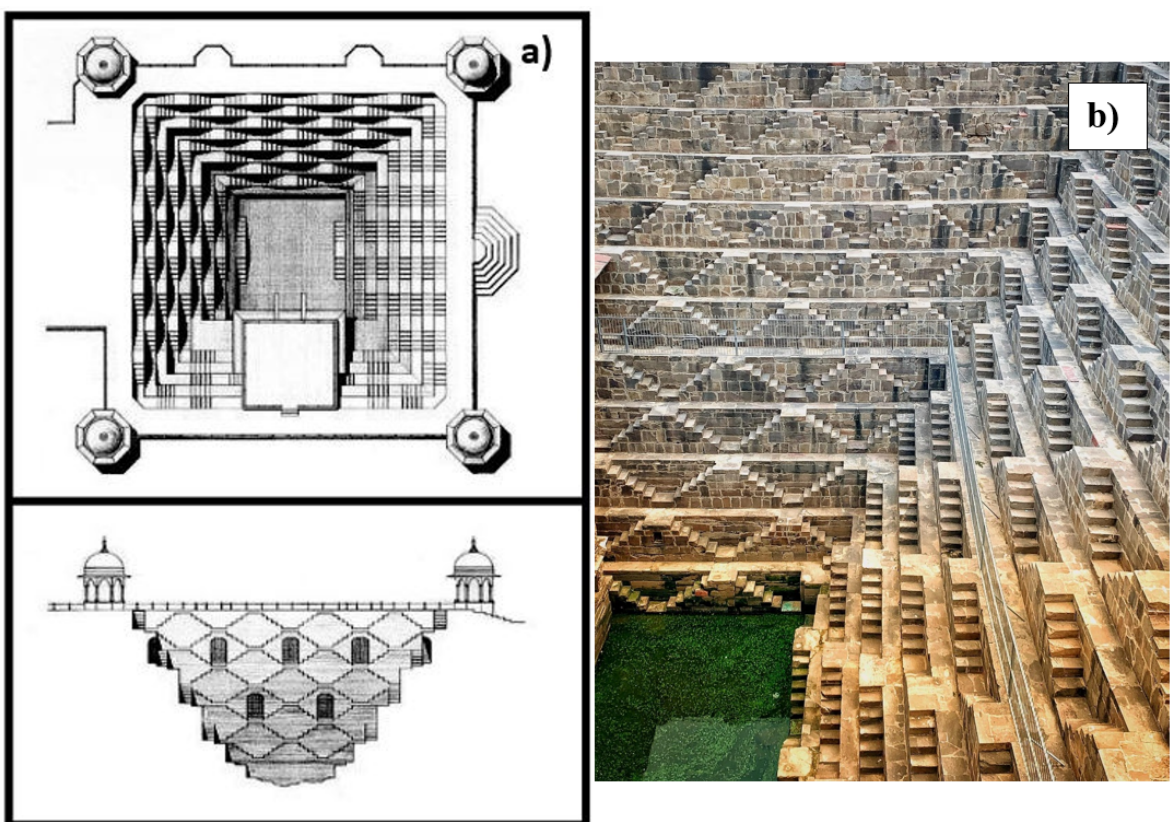
Figure 10. Chand Baori: ( a ) Plan and elevation view https://in.pinterest.com/pin/119626933831362019/, accessed on 20 July 2022 and ( b ) bird’s eye view of the structure. (https://10.16943/ijhs/2020/v55i2/154675, accessed on 20 July 2022).